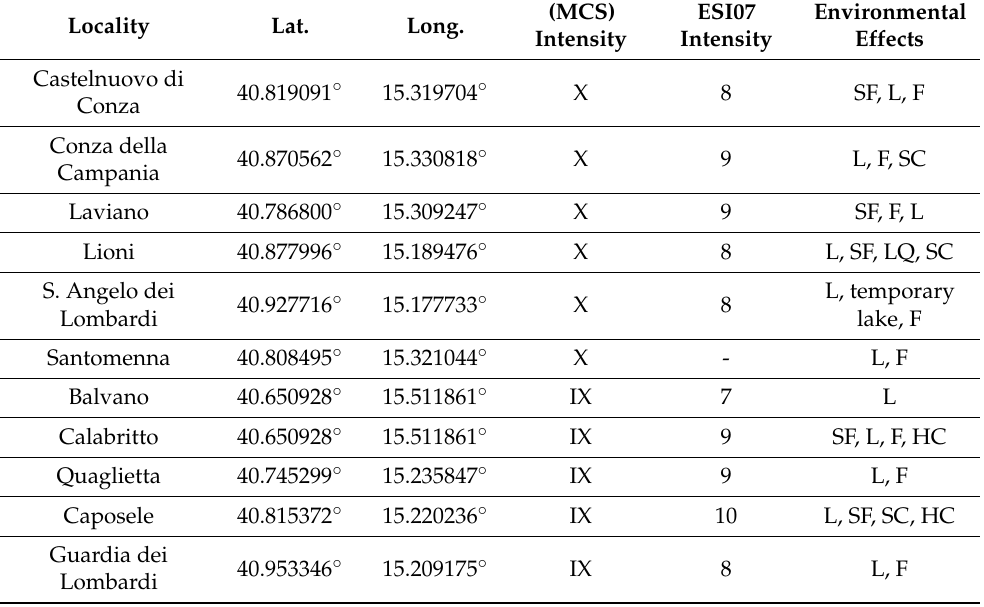
Figure 2. Environmental effects induced in the epicentral area by the 23 November 1980 Irpinia-Basilicata earthquake [21]. The Ortophoto image from Google Earth. Table 1. The table contains the visited localities, their geographic coordinates and MCS and ESI intensity with the most significant environmental effects observed after the 1980 earthquake (SF surface fault; F fractures, L landslide, SC Soil Compaction, HC Hydrological Changes, LQ Liquefaction) [1–3,11,12,14,19–23,25–27]. Locality